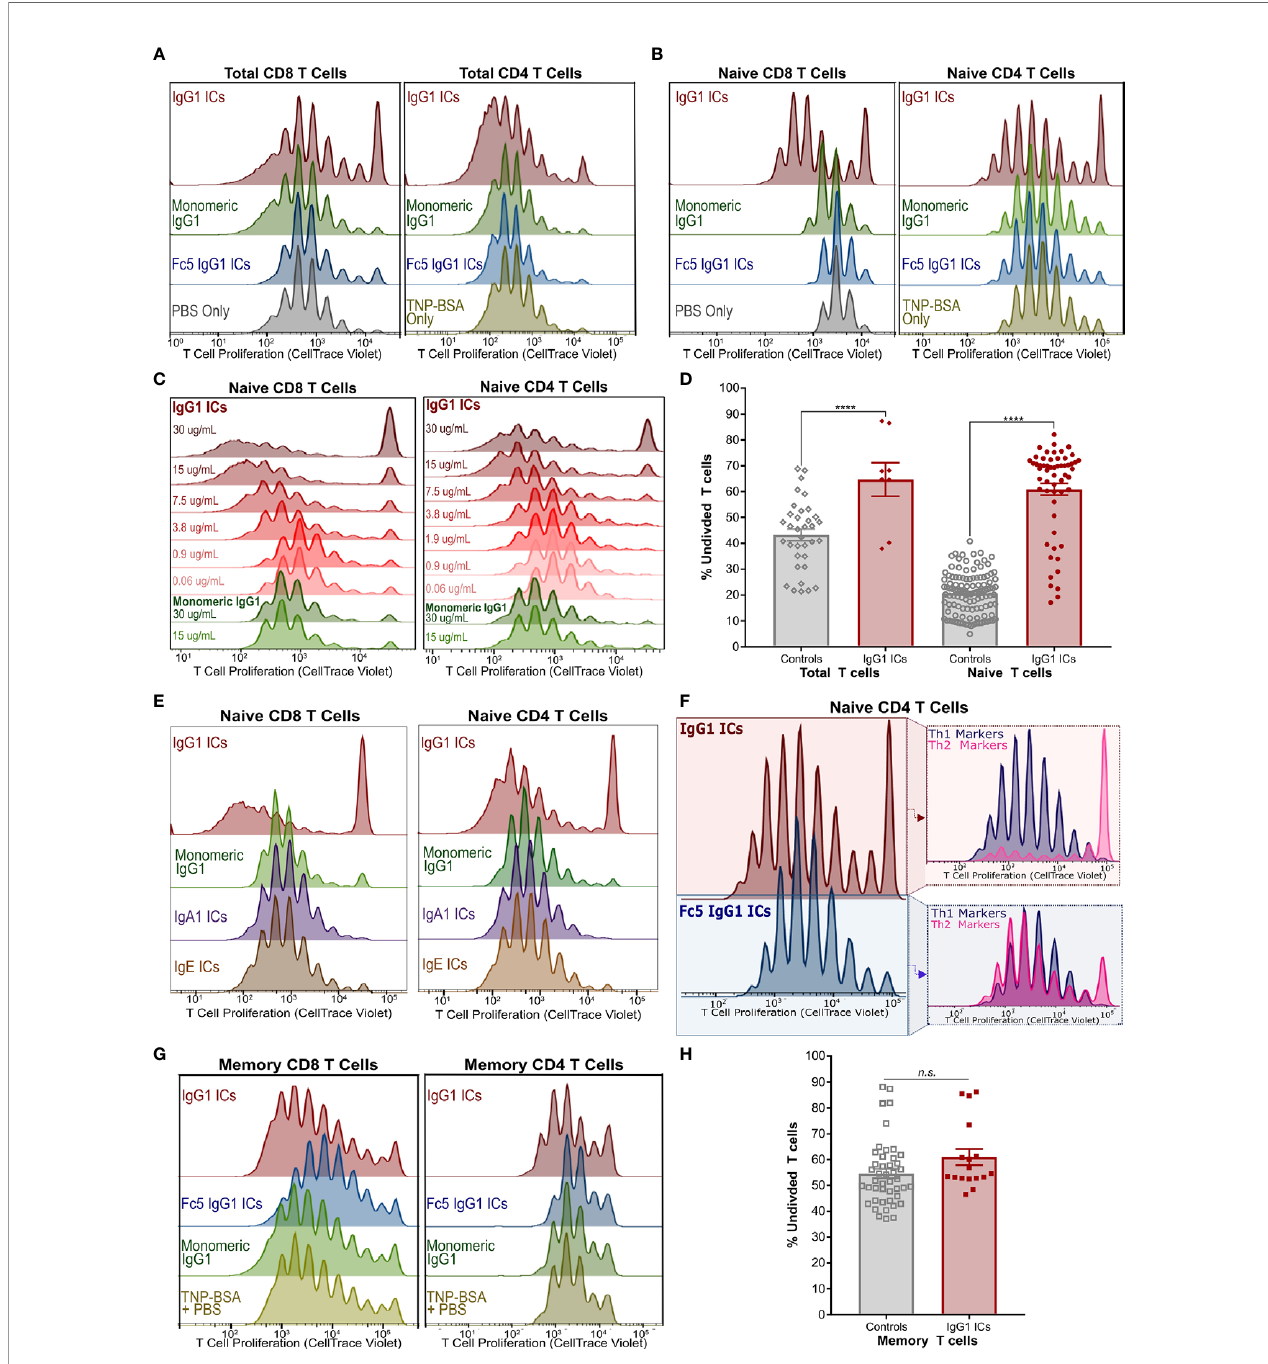
FIGURE 2 | IgG Immune Complexes Inhibit Naïve T Cell Proliferation but Stimulate a Subset of Their Progeny (A) Proliferation of activated CellTrace-stained Total CD8+ (left) and CD4+ (right) T cells incubated with IgG1-ICs or indicated controls (representative of 3 independent experiments/donors). (B) Proliferation experiment described in (A) with puri fi ed naïve CD8+ (left) and naïve CD4+ (right) T cells (representative of 8 independent experiments using 7 unique human donors for CD8+; 5 independent experiments/donors for CD4+). (C) Proliferation of activated naïve CD8+ and CD4+ T cells incubated with varying concentrations of IgG1-ICs (various shades of red) or monomeric IgG1 (green). (D) Summary of total and naïve T cell proliferation data (E) Proliferation experiments described in (A) with representative results for IgA1-ICs and IgE-ICs. (F) Activated naïve CD4+ T cells incubated with IgG1-ICs or Fc5 IgG1-ICs, cultured for 5-7 days, and stained with anti-CXCR3 and anti-CCR6 mAbs to examine Th1-like (CXCR3+ CCR6-) and Th2-like (CXCR3- CCR6-) phenotypes (representative of 4 independent experiments/donors). (G) Proliferation experiment described in (A) performed using enriched memory CD8+ T cells (representative of 3 independent experiments/donors for CD8+; 4 independent experiments/donors for CD4+). (H) Summary of memory T cell proliferation data. “ **** ” indicates p-values < 0.0001 (one-way ANOVA). “ n.s. ” stands for statistically not signi fi cant. A tabulated summary of all proliferation experiments (N=26) for individual donors is provided in Table S2